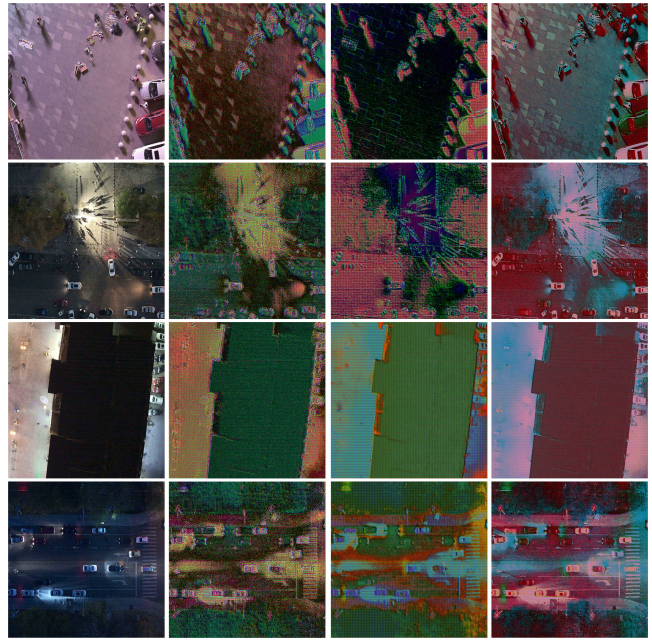
Figure 9. Samples of the four GAN models. From left to right are the visible images, images generated by GAN, images generated by detection task oriented GAN and GAN with detection features enhanced in our models.